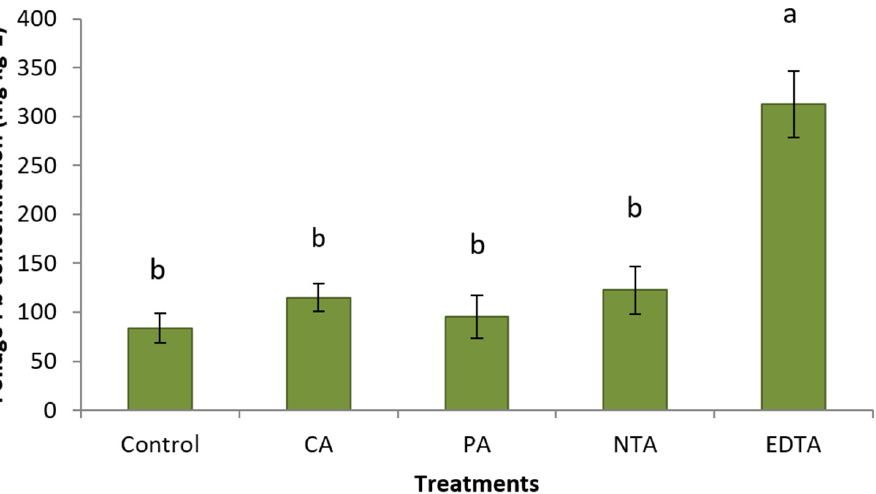
Figure 1. Average (+/- SD) foliage Pb concentration (mg kg − 1 ) of Panicum virgatum at time of harvest. The means for columns designated with the same letter are not statistically significantly different ( α = 0.05). Treatments labeled: CA = Citric Acid 10 mM; PA = Phytic Acid 10 mM; NTA 1 mM and EDTA 1 mM.